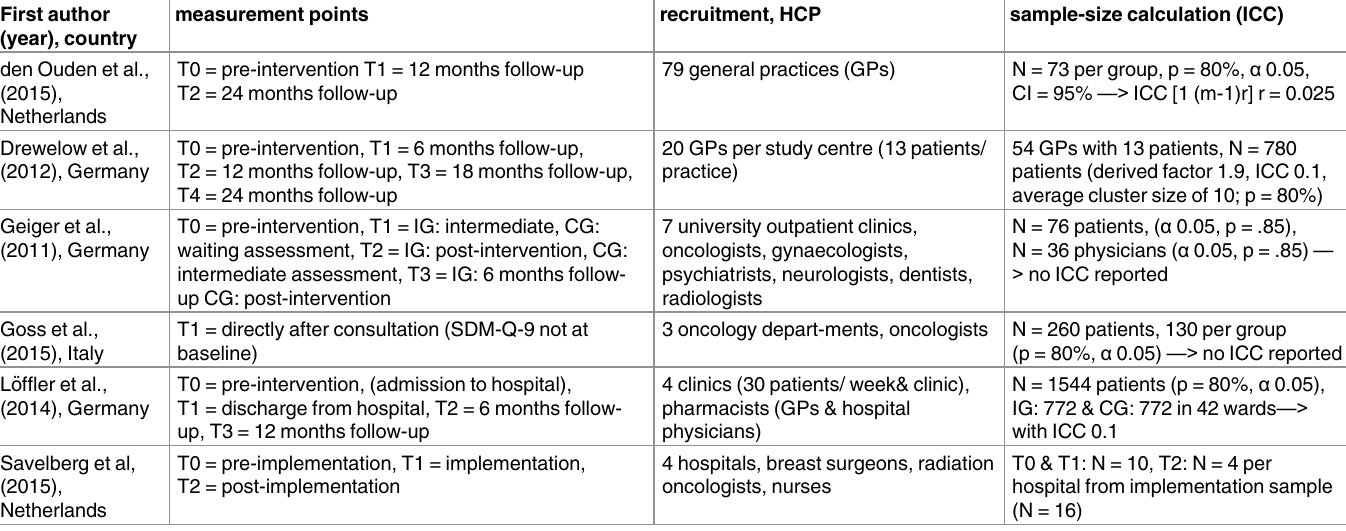
Table 5. Characteristics of the included study protocols